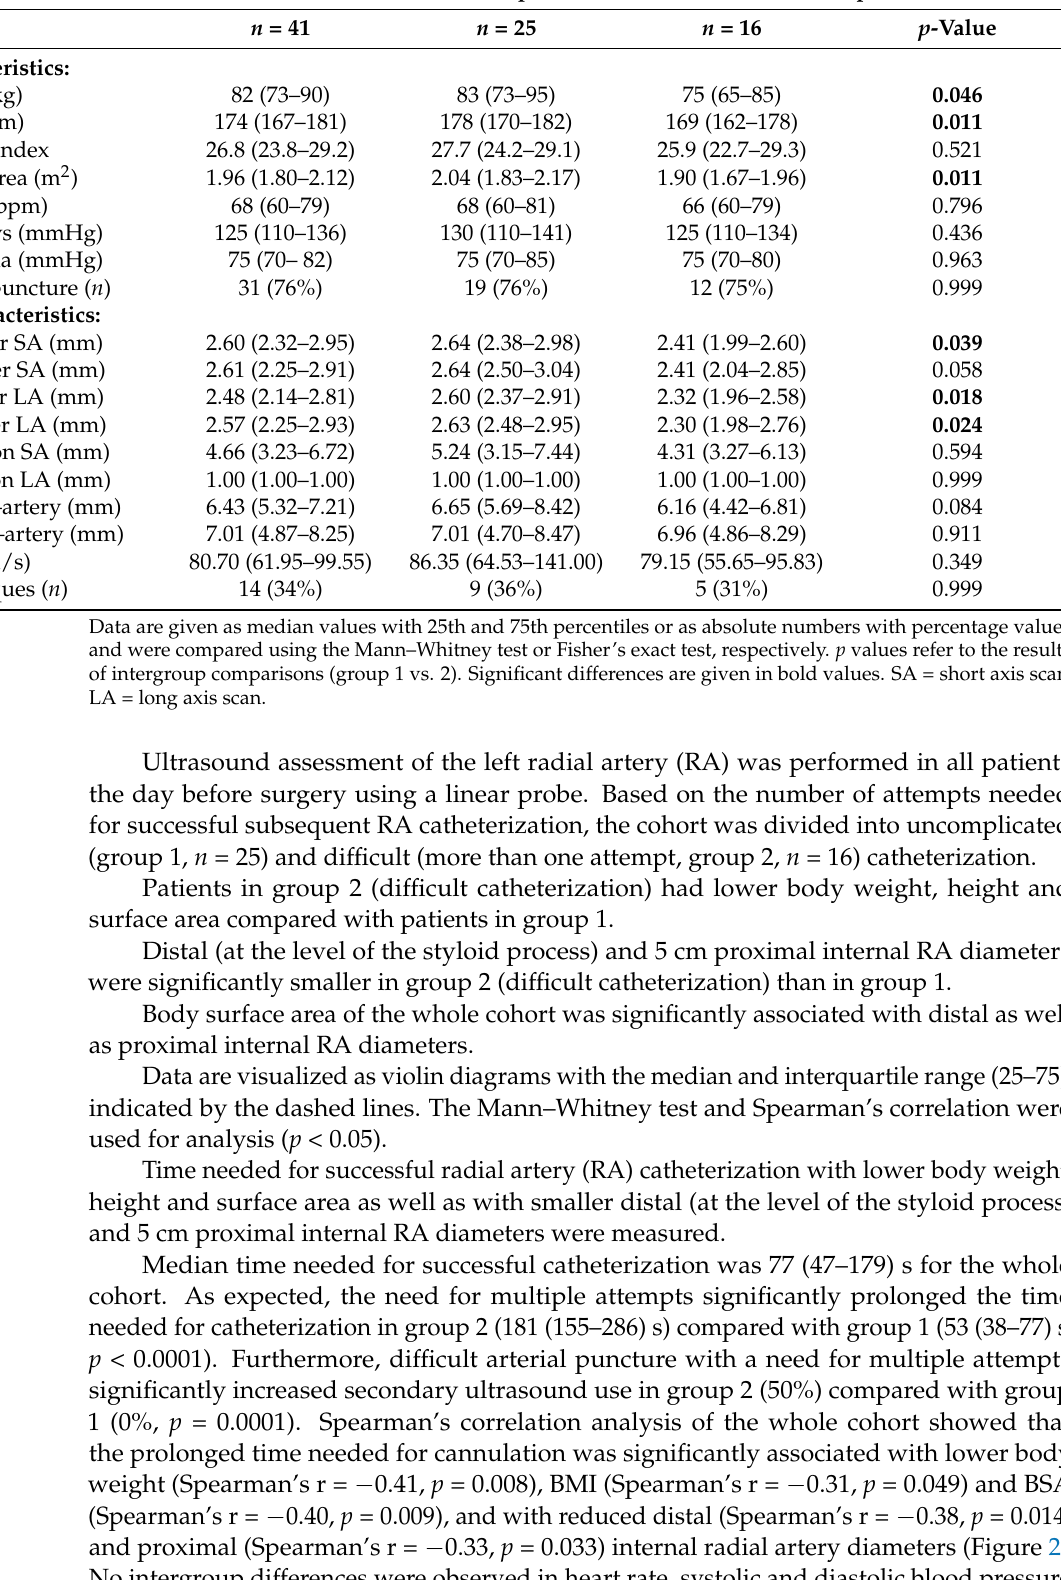
Table 1. Results of preoperative ultrasound assessment of patients in the whole cohort as well as patients in group 1 (uncomplicated catheterization) and group 2 (difficult catheterization). Whole Cohort Group